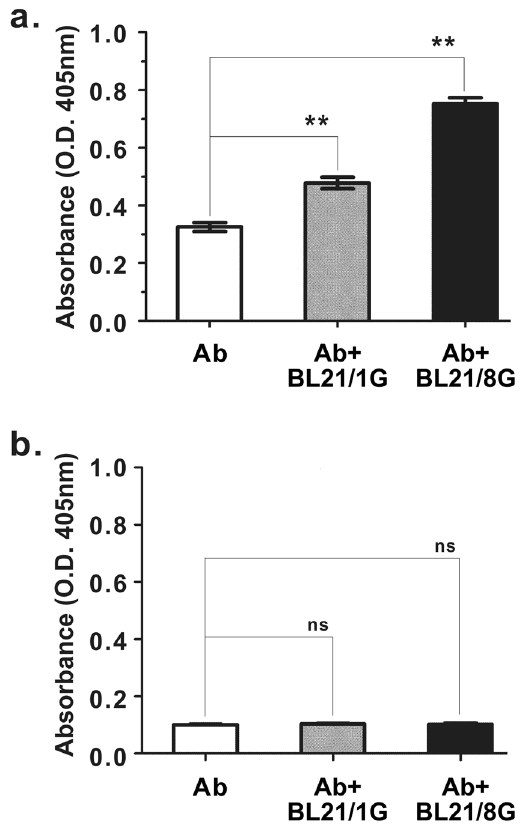
Figure 5. ELISA tests performed in the presence and absence of poly-protein G-expressing bacteria. Anti-PEG antibody (6.3-biotin) mixed with BL21/1G cells or BL21/8G cells, or not mixed with anything, was added into 96-well plates coated with ( a ) PEG 5k -BSA or ( b ) BSA. The binding amount of 6.3-biotin was determined by measuring absorbance at 405 nm after staining with SA-HRP and ABTS. Ab, 6.3-biotin. Statistical analysis was performed by one-way ANOVA. Bar, SD. ns, no significant difference. ** P value <